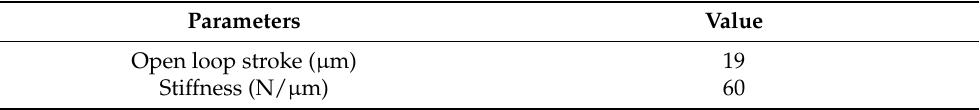
Table 1. Parameters of Pst150/7/20 VS12.